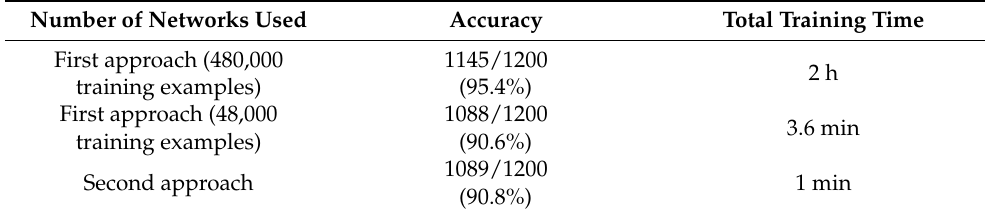
Table 4. Comparison between the results of the first and the second approach.